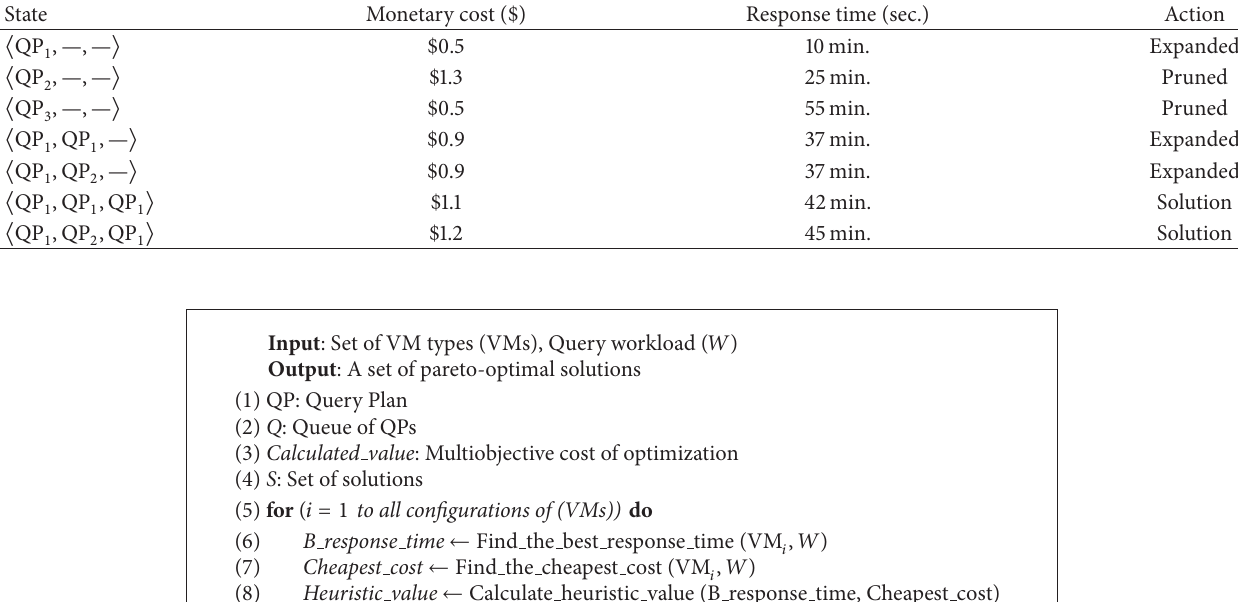
Table 7: Execution of multiobjective branch-and-bound algorithm with heuristic values (monetary cost = $1.2 and response time = 50 min.). State